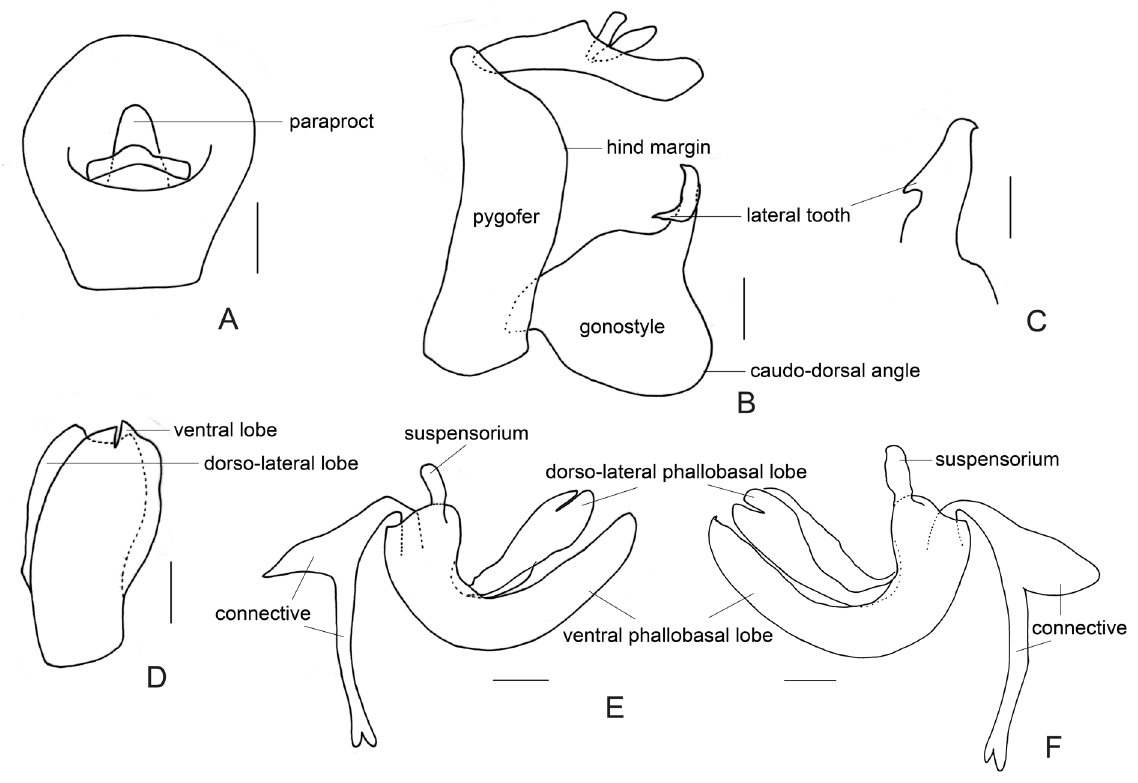
Fig. 3. Gergithus frontilongus sp. nov. A . Male anal tube, dorsal view. B . Male genitalia, lateral view. C . Capitulum of gonostyle, dorsal view. D . Phallobase, ventral view. E . Penis, left view. F . Penis, right view. Scale bars = 0.2